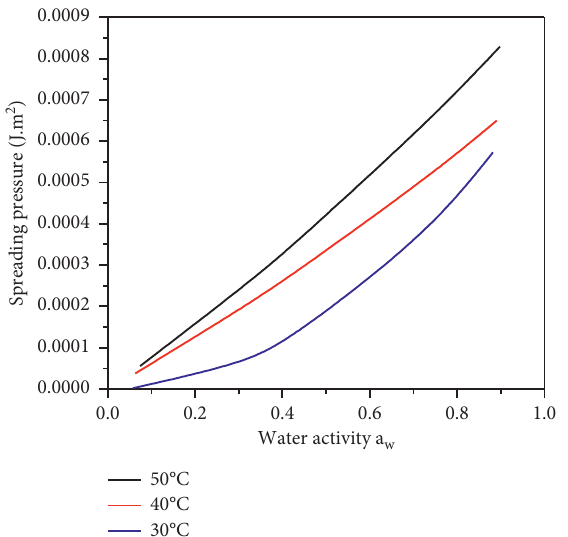
Figure 8: Spreading pressure isotherms at different